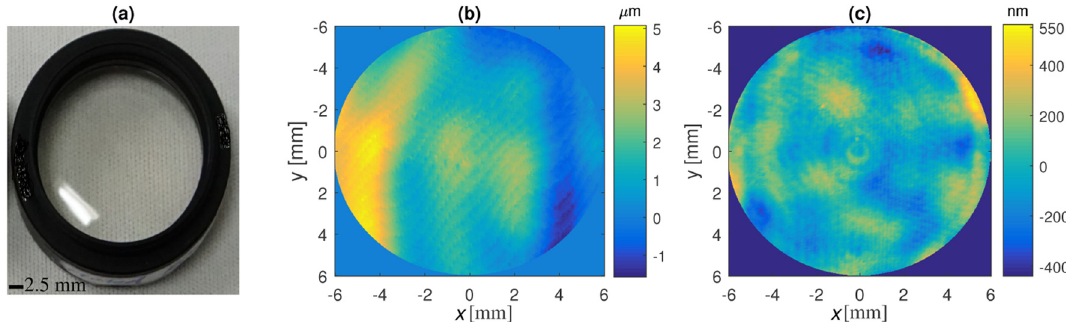
Figure 1: ( a ) 3D printed lens with 25 mm clear aperture; ( b ) surface pro fi le error before iteration; and ( c ) surface deviation after fi ve iterations. From ref. ( 49 ) , originally published under an open - access